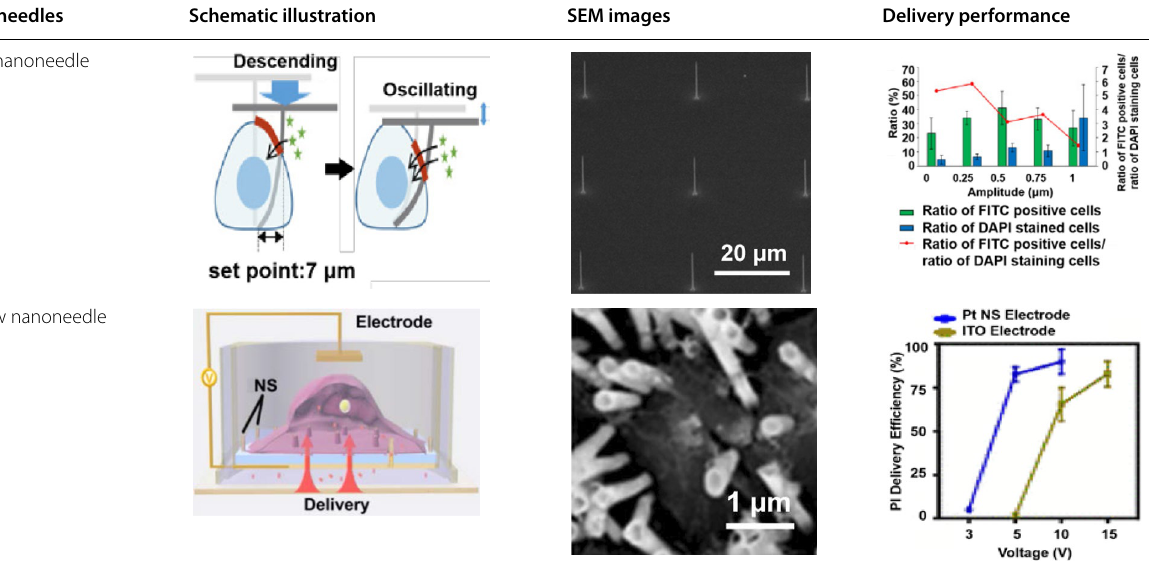
Table 4 Cell drug delivery applications of